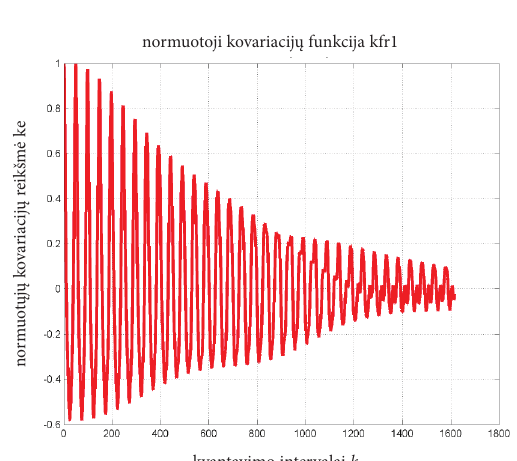
3 pav . Normalių moteriškųjų ląstelių pirmosios 21-osios 6 pav . Normalių ir patologinių moteriškųjų ląstelių pirmosios chromosomos normuotoji kovariacijų funkcija 21-osios chromosomos ir priedinės (trečiosios) 21-osios chromosomos tarpusavio normuotoji kovariacijų funkcija Fig. 3 . Normalised covariance function of the normal female first chromosome 21 in cells Fig. 6 . Interrelation normalised covariance function of the normal and abnormal female first and extra (third) chromosome 21 in cells